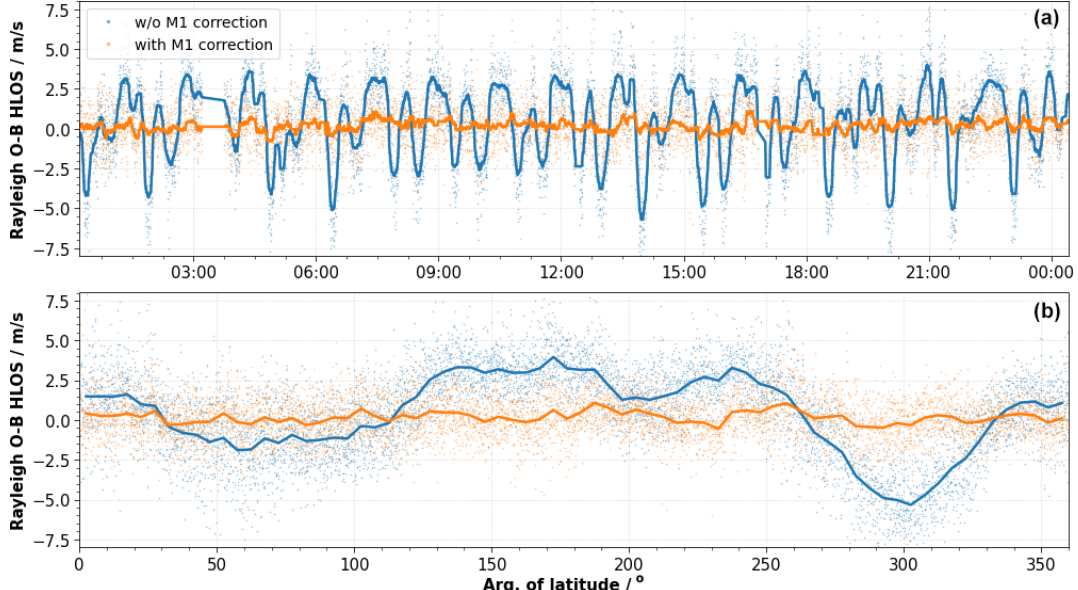
Figure 9. Rayleigh clear E(O − B) HLOS values as a function of time (a) and the argument of latitude (b) during 12 August 2019. The blue and the orange dots indicate the bias without and with M1 bias correction, respectively. The blue and the orange lines show temporal (5min interval) and binned (5 ◦ bin size for the argument of latitude) averages of the E(O − B) values, respectively. The M1 bias correction coefficients are derived from data from 11 August